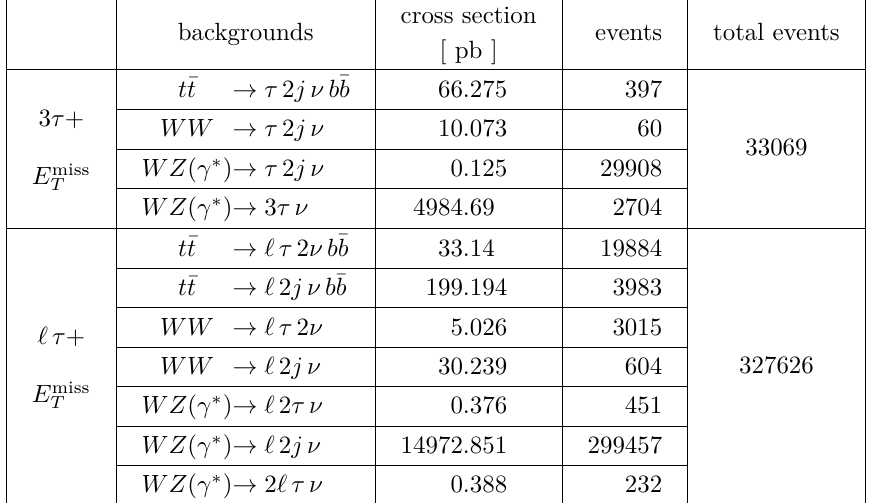
Table 6 . Estimate of the background events for the integrated luminosity, L = 100 fb − 1 .